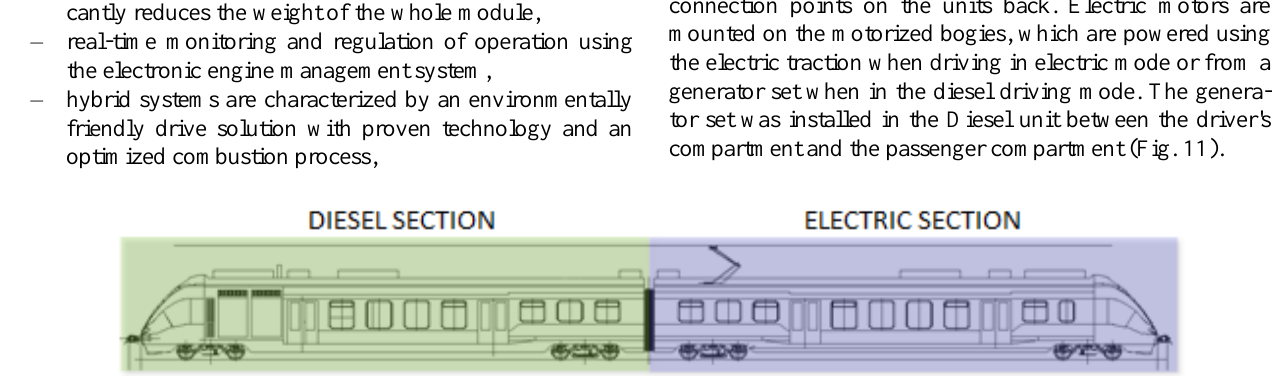
Fig. 10. Diesel and Electric modules of the type 227M rail